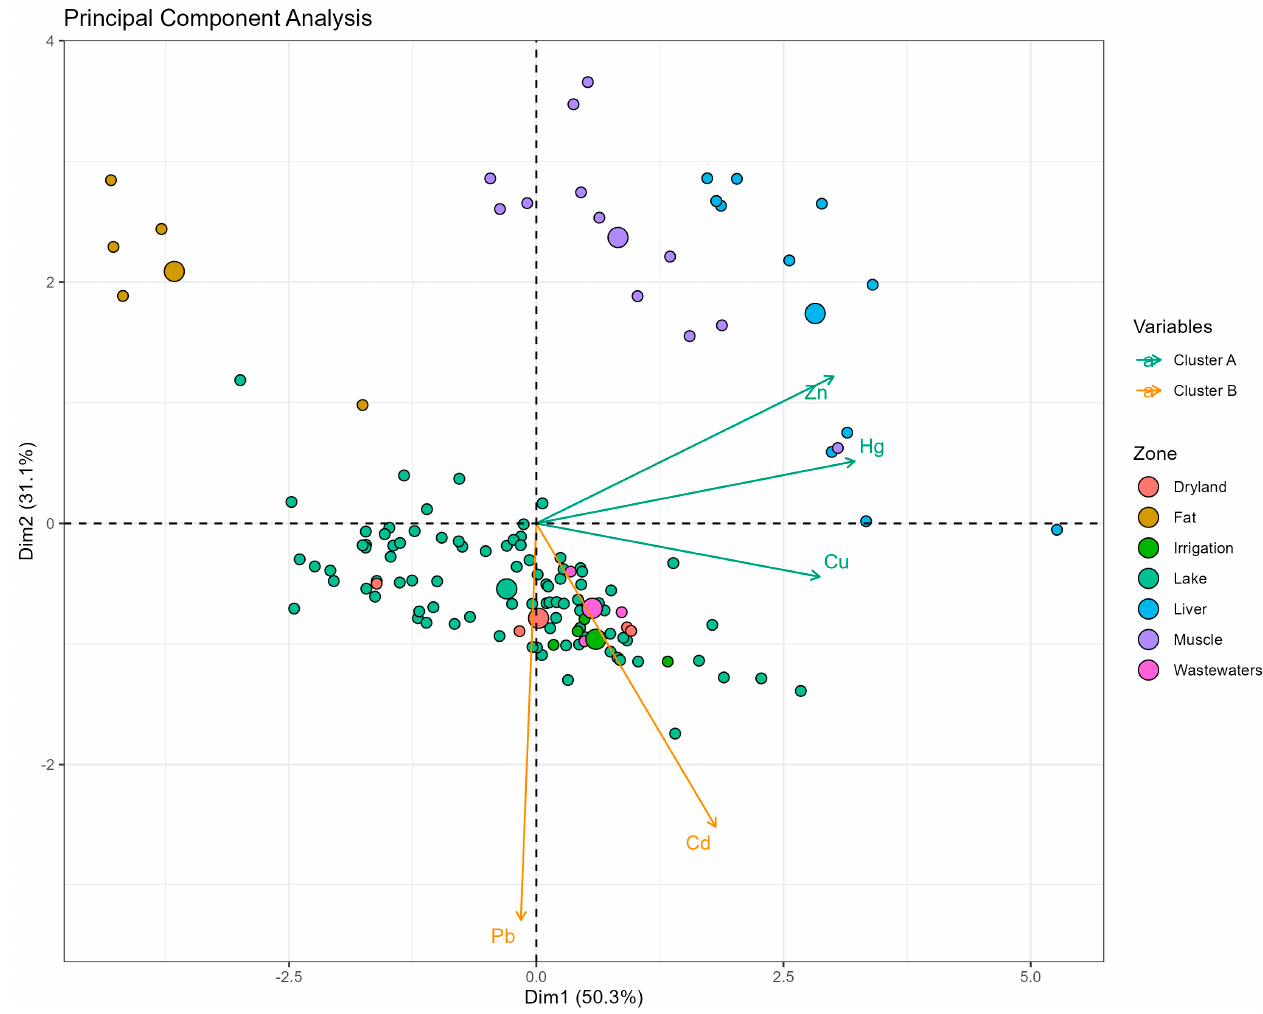
Figure 4. PCA analysis of the log-transformed variables depicting the two main principal components (PC) of parameter loading with the two defined clusters labeled in green and orange (clusters A and B, respectively). The two PCA axes explain 81.4% of total variability in the